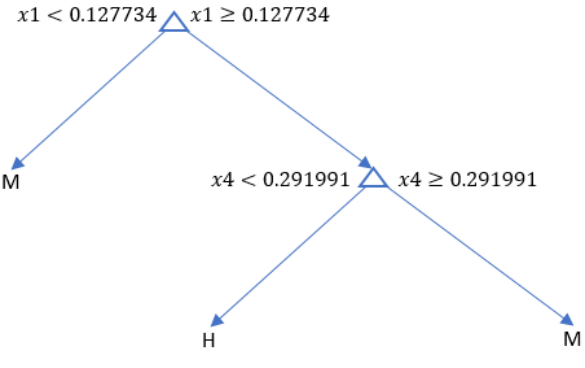
Figure 14. Constructed decision tree in case 1.